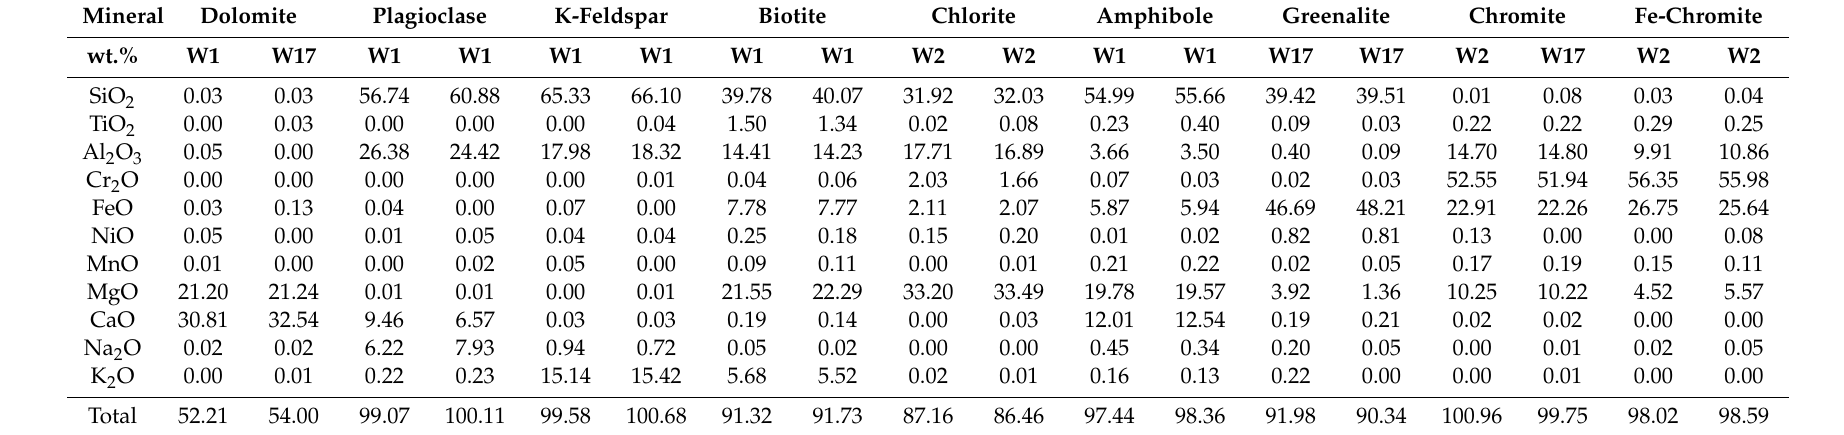
Table 5. Representative analyses (EMPA) of the listvenite samples